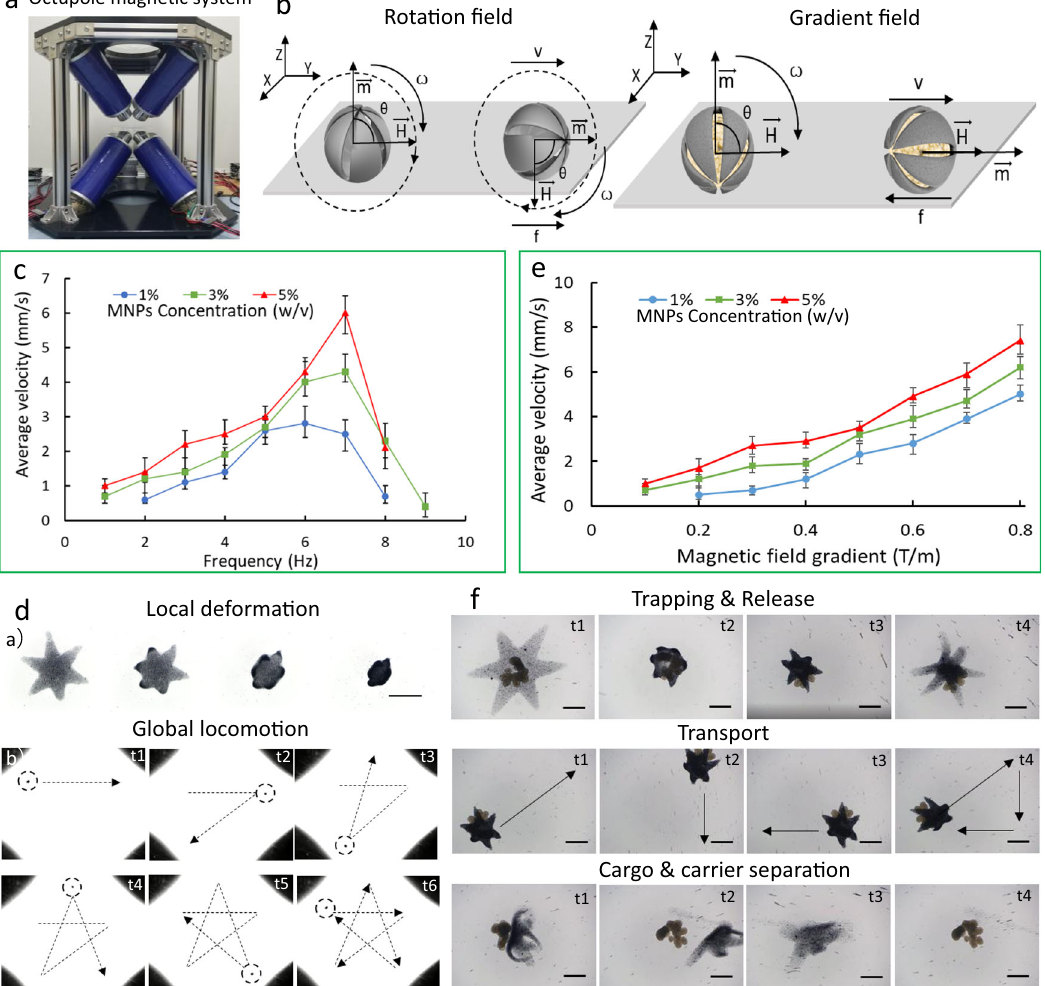
Fig. 5 Manipulation of an ISME with encapsulated MNPs under different magnetic fi elds. a Octupole magnetic system used in the experiment. b Schematic illustration of the magnetic actuation of an ISME under a rotating fi eld and a gradient fi eld, wherein V represents the translational velocity, H denotes the strength of the magnetic fi eld, m indicates the direction of magnetization of the ISME, f represents the force of friction, ω indicates the rotation velocity of the microsphere, and θ denotes the tilt angle between the direction of the magnetic fi eld and the direction of magnetization of the ISME. c Velocity – frequency pro fi les for ISMEs with different MNP concentrations (1%, 3%, and 5%) under a rotating magnetic fi eld. Each dot represents the average velocity for fi ve different ISMEs with hexagram shapes ±s.e.m. (standard error of the mean). d (a) Images of the ISME with encapsulated MNPs during folding transformation in response to a pH change. Scale bar: 500 μ m. (b) Time series of the rotating- fi eld-controlled locomotion of an ISME with time instants marked and motion trajectories delineated. Scale bar: 4 mm. e Velocity – frequency pro fi les of ISMEs with different MNP concentrations (1%, 3%, and 5%) under a gradient magnetic fi eld. Each dot represents the average velocity for fi ve different ISMEs with hexagram shapes ±s.e.m. (standard error of the mean). f Images of MNP-loaded ISMEs performing the capture, transportation, and release of cell aggregates, separation following release, and eventually dissolution in response to a pH change. Scale bar: 250 μ m. Source data is provided as a Source Data fi